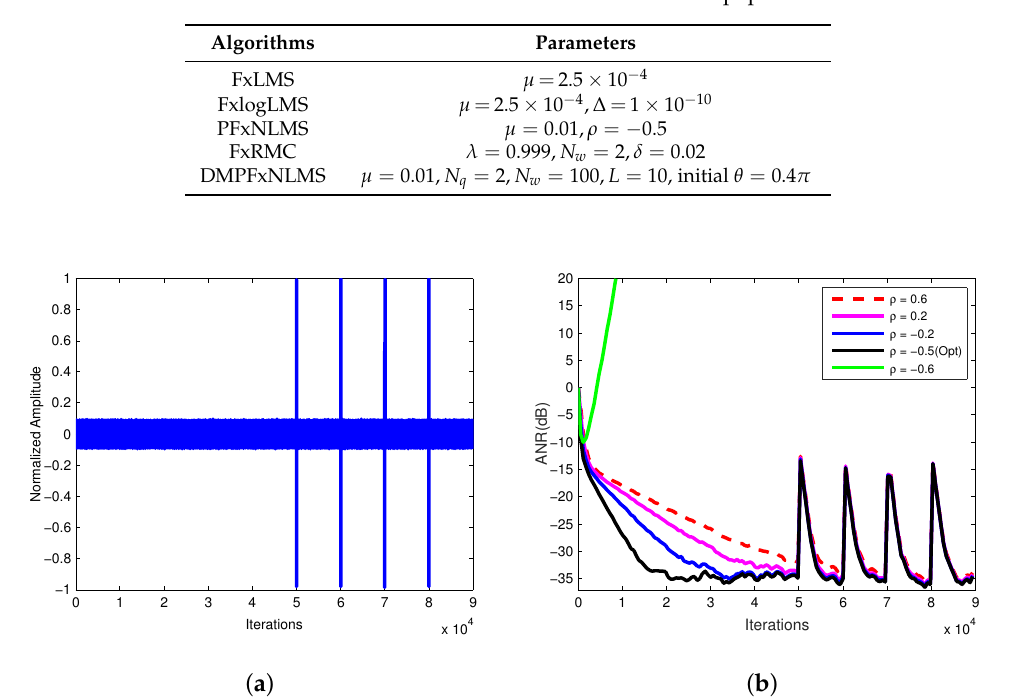
Table 3. Parameters for different methods in this paper.